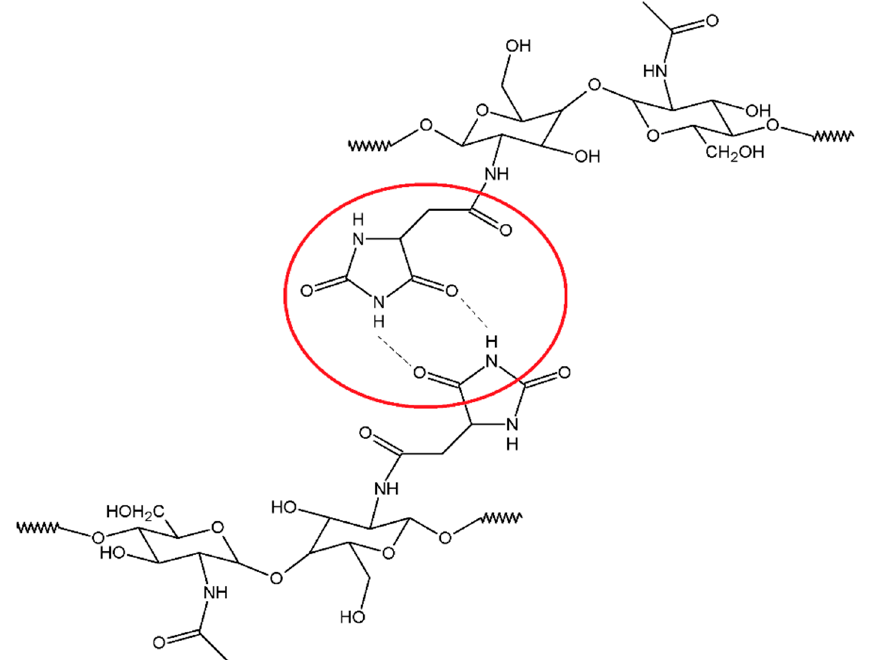
Figure 3. Possible interactions between CS-CMH macromolecules.